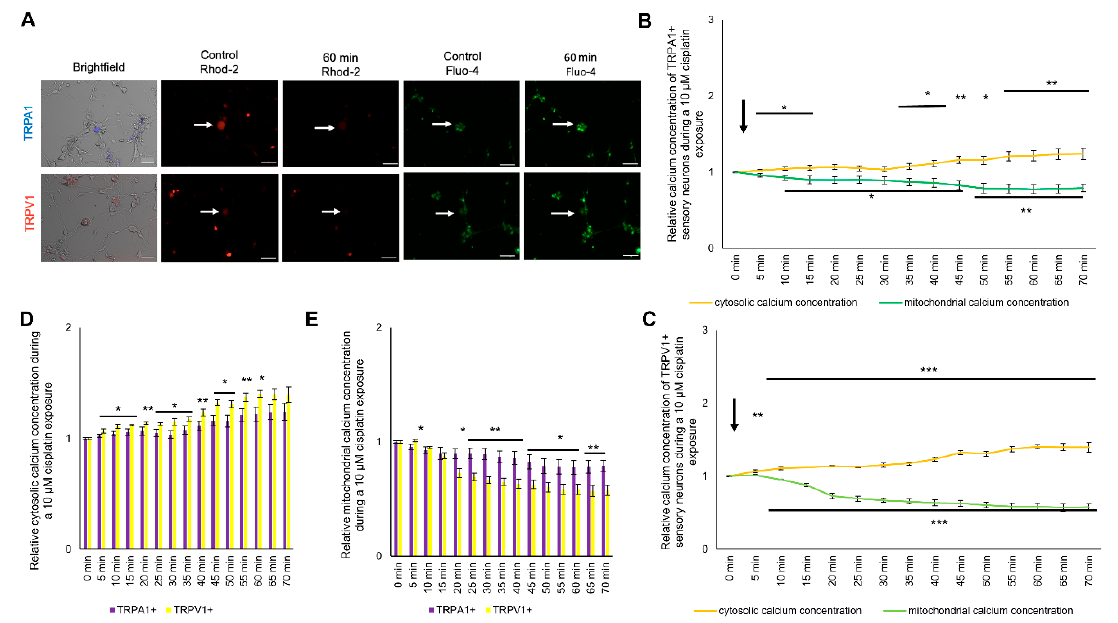
Figure 3. Cytosolic and mitochondrial calcium concentration of TRPA1- or TRPV1-positive DRG neurons during exposure to 10 µ M cisplatin. ( A ) Immunostaining of transient receptor potential ankyrin 1 (TRPA1)- or transient receptor potential vanilloid 1 (TRPV1)-positive DRG neurons and live imaging of Fluo-4 (green) and Rhod-2 (red). ( B ) The cytosolic calcium of TRPV1-positive DRG neurons concentration instantly increased to 1.067 ± 0.018 (* p < 0.05) after 5 min and continuously increased to 1.394 ± 0.068 (** p < 0.01) after 70 min. The mitochondrial calcium concentration declined to 1.095 ± 0.009 (* p < 0.05) after 5 min for TRPV1-positive DRG neurons and steadily declined to 0.577 ± 0.044 after 70 min (** p < 0.01). ( C ) During the exposure of 10 µ M cisplatin, the cytosolic calcium concentration of TRPA1-positive neurons increased after 5 min to 1.024 ± 0.011 (** p < 0.01) until 70 min at 1.240 ± 0.074 (*** p < 0.001). The mitochondrial calcium concentration was lower after 10 min at 0.928 ± 0.029 (*** p < 0.001) until it reached 0.790 ± 0.050 at 70 min (*** p < 0.001). ( D ) The cytosolic calcium concentration of TRPV1-positive DRG neurons was increased after 15 min to 65 min compared to TRPA1-positive DRG neurons (* p < 0.05, ** p < 0.01). ( E ) The mitochondrial calcium concentration of TRPA1- or TRPV1-positive DRG neurons was di ff erent after 5 min until the end of the experiment (* p < 0.05, ** p < 0.01). TRPV1-positive sensory neurons had a lower mitochondrial calcium concentration during exposure to 10 µ M cisplatin after 15 min (* p < 0.05, ** p < 0.01). n = 6 cells per condition. * = significant e ff ect between TRPA1 + and TRPV1 + DRG neurons. Scale = 50 µ